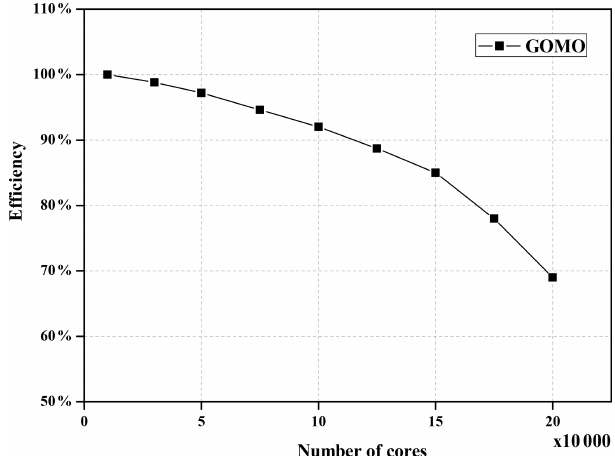
Figure 13. Parallel efficiency of GOMO on the Sunway